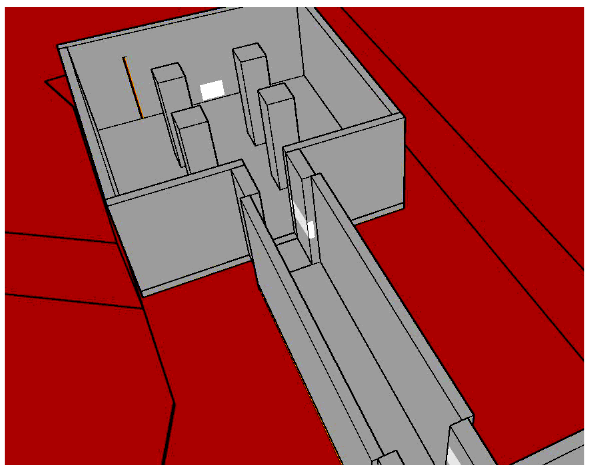
Figure 4. Simulation of lighting condition with the hypaethral opening above the main entrance